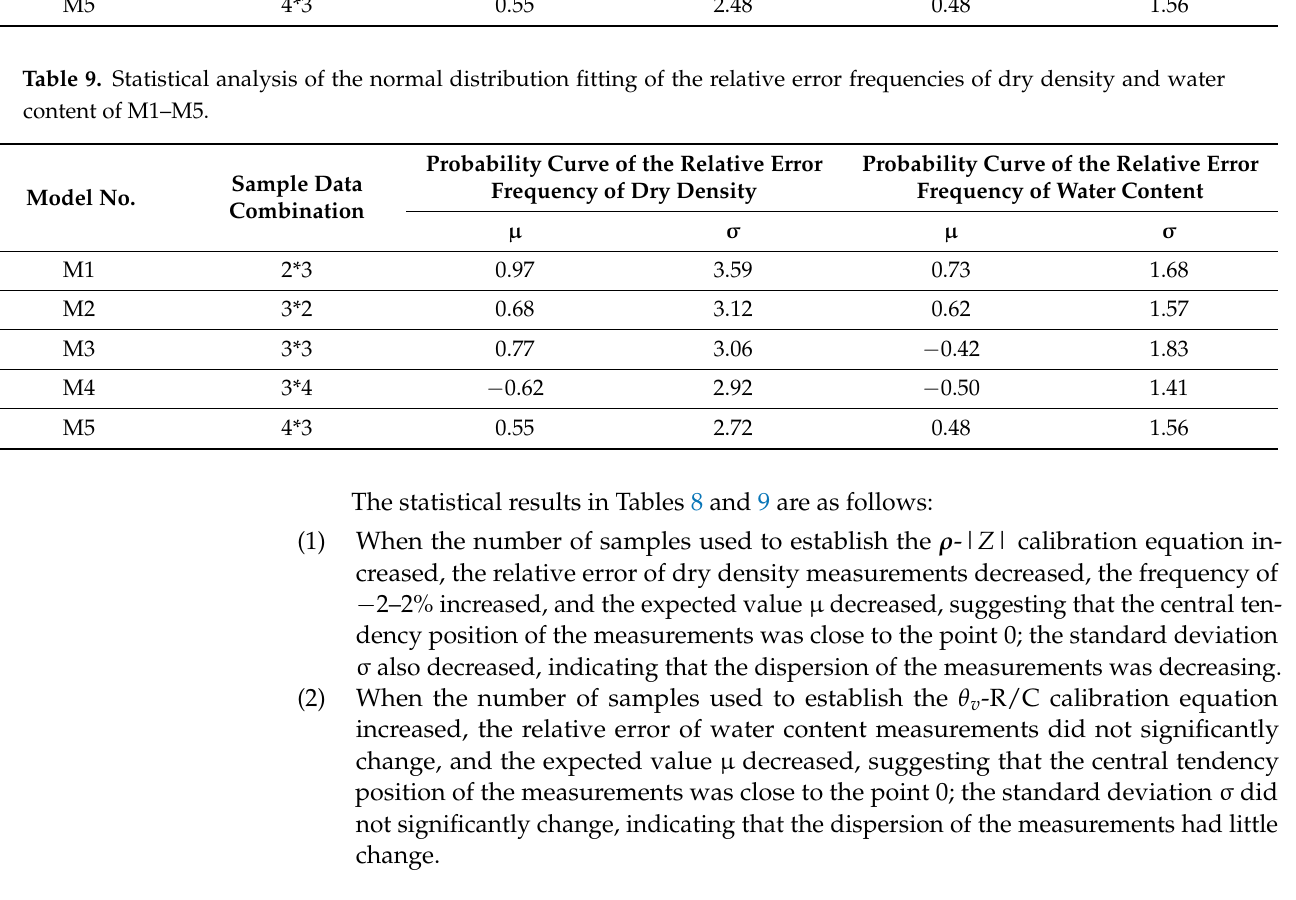
Table 9. Statistical analysis of the normal distribution fitting of the relative error frequencies of dry density and water content of M1–M5.